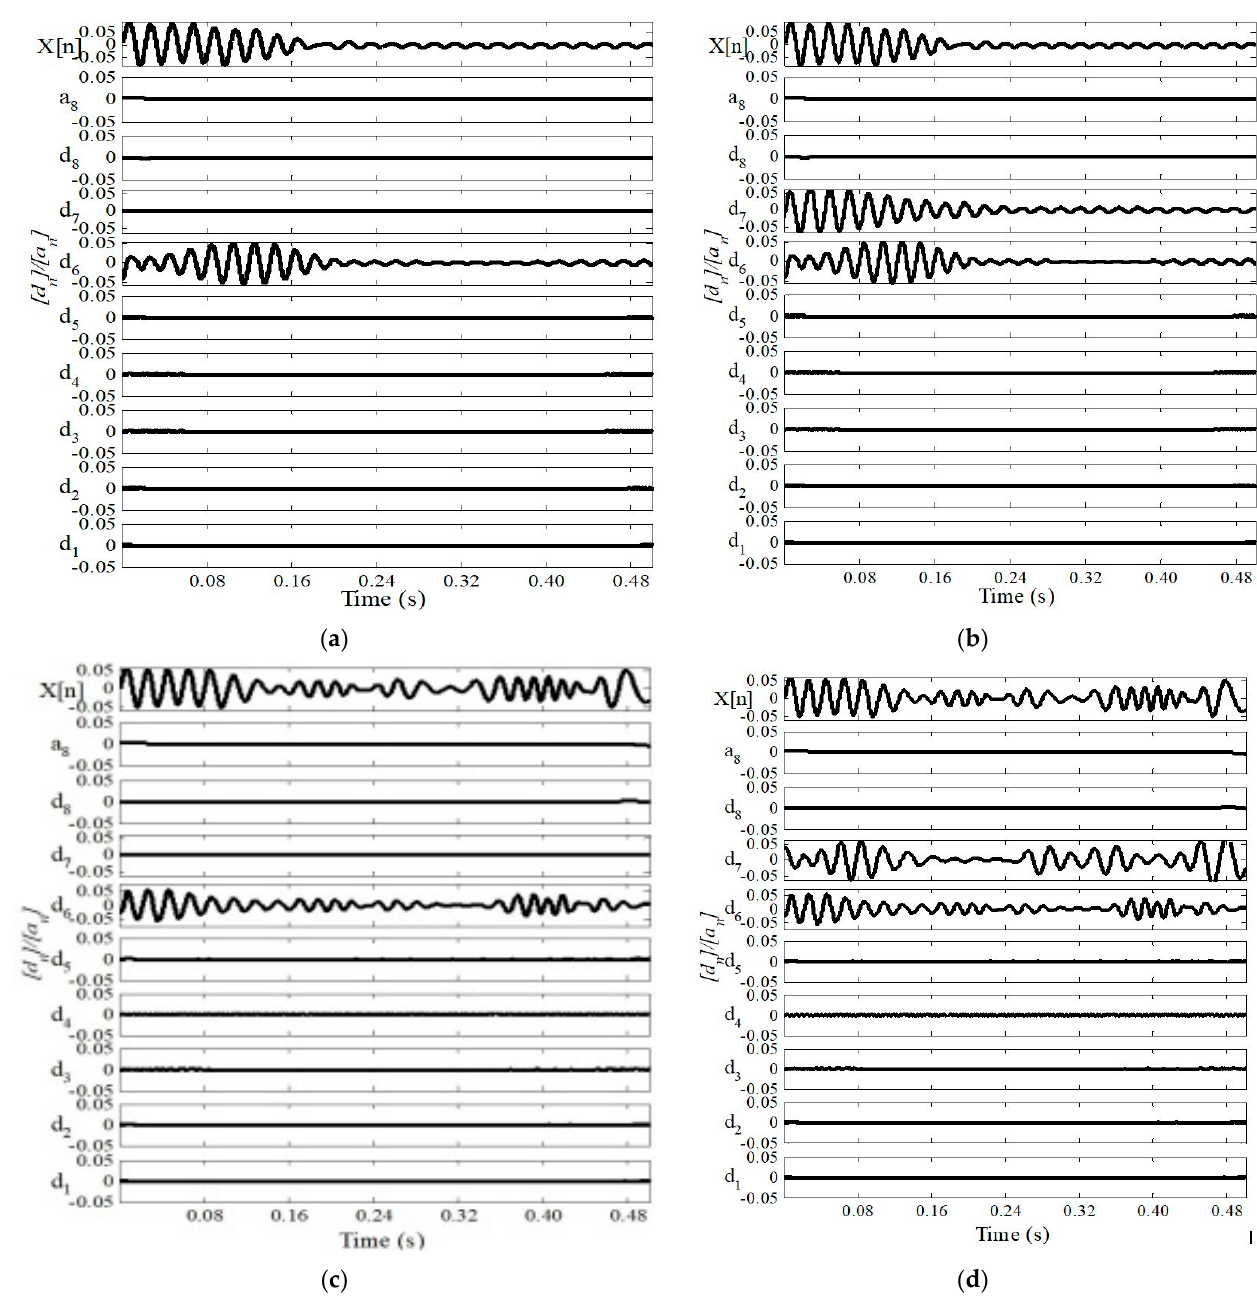
Figure 4. Approximated [ a n ] and detailed [ d n ] coefficients obtained by the DWT-based MRA of phase-a current of 5.5 kW SCIM running at a rated load torque: Under constant frequency operation: ( a ) In the absence of cage fault, ( b ) in the presence of cage fault, and under frequency regulation: ( c ) In the absence of cage fault, ( d ) in the presence of cage fault.